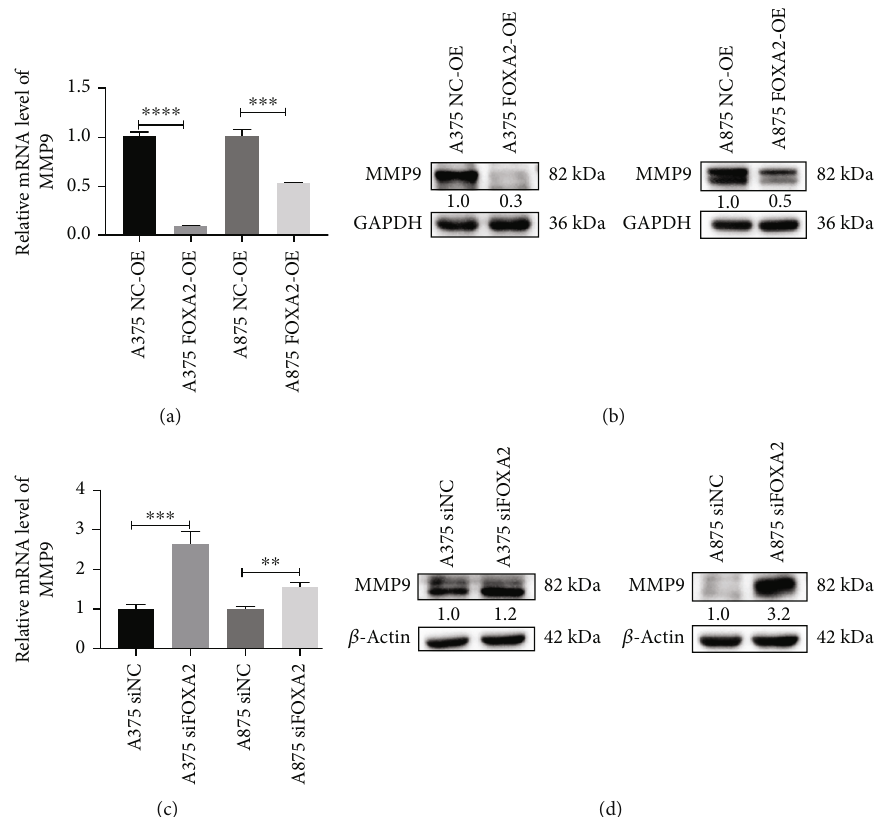
Figure 10: FOXA2 inhibits MMP9 transcription. (a, b) RT-qPCR and western blotting analyses of the mRNA and protein expression of MMP9 in NC-OE and FOXA2-OE melanoma cells. (c, d) RT-qPCR and western blotting analyses of the mRNA and protein expression of MMP9 in control and FOXA2-silenced melanoma cells. ∗∗ p < 0 : 01 , ∗∗∗ p < 0 : 001 , and ∗∗∗∗ p < 0 : 0001 vs. control